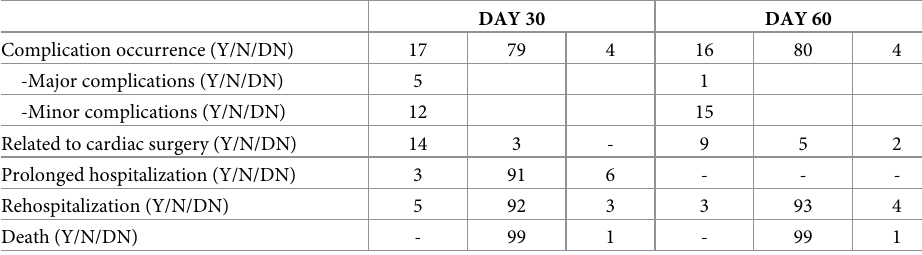
Table 3. Extra-hospital events at Day 30 and Day 60. Y = yes, N = no, and DN = don’t know.